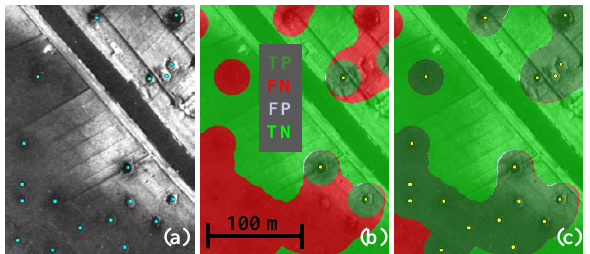
Figure 2: Subset of image I with the reference centres of the bomb craters in turquoise (a) and the superimposition of the corresponding impact map and its evaluation with TP-areas in dark green, FN-areas in red, FP-areas in pale blue and TN-areas in lime green for non- combined (b) and combined (c) detection results.